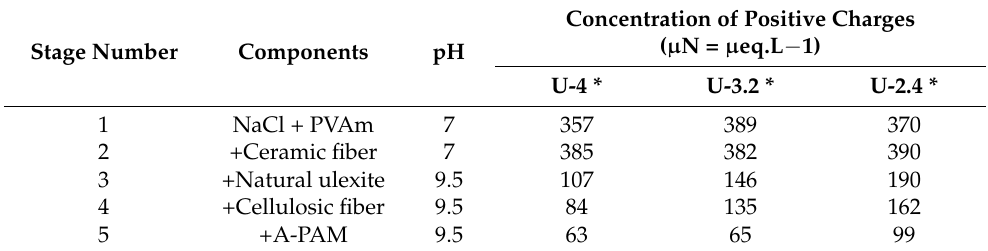
* U-X indicates the suspension used for the preparation of ceramic paper with the different amounts of binder (X).